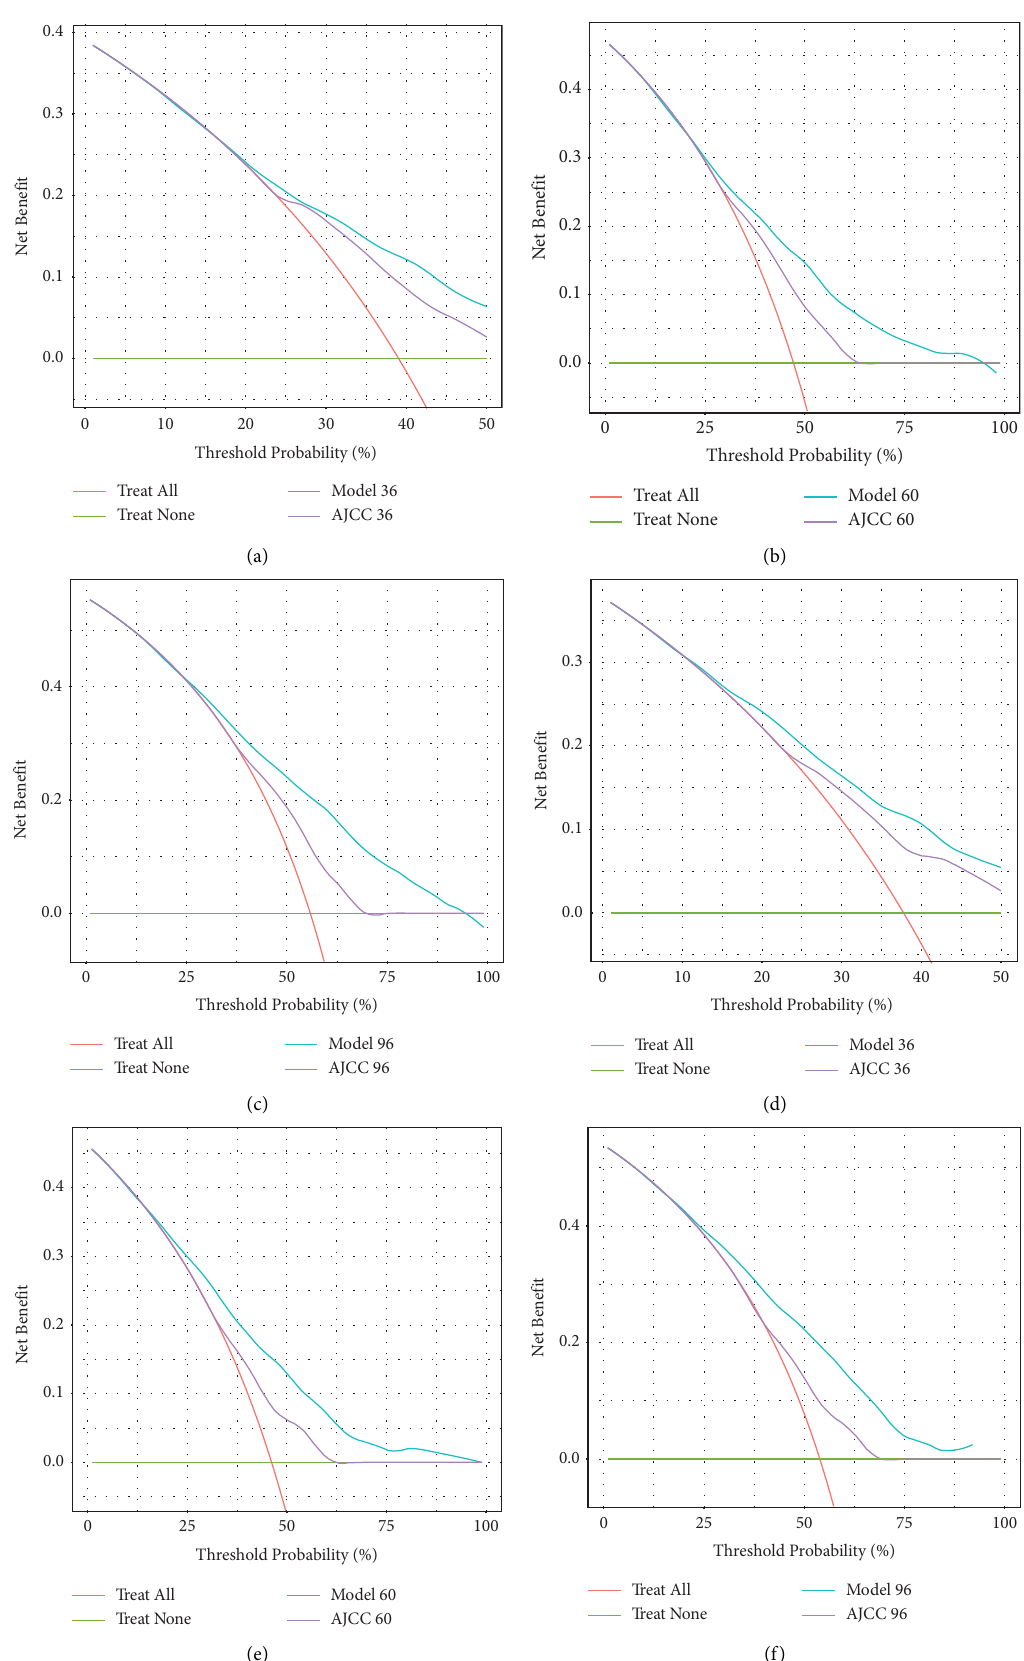
Figure 5: Decision curve analysis curves. Decision curve analysis of the training cohort (a–c) and validation cohort (d–f) for 3-, 5-, and 8- year cancer overall survival